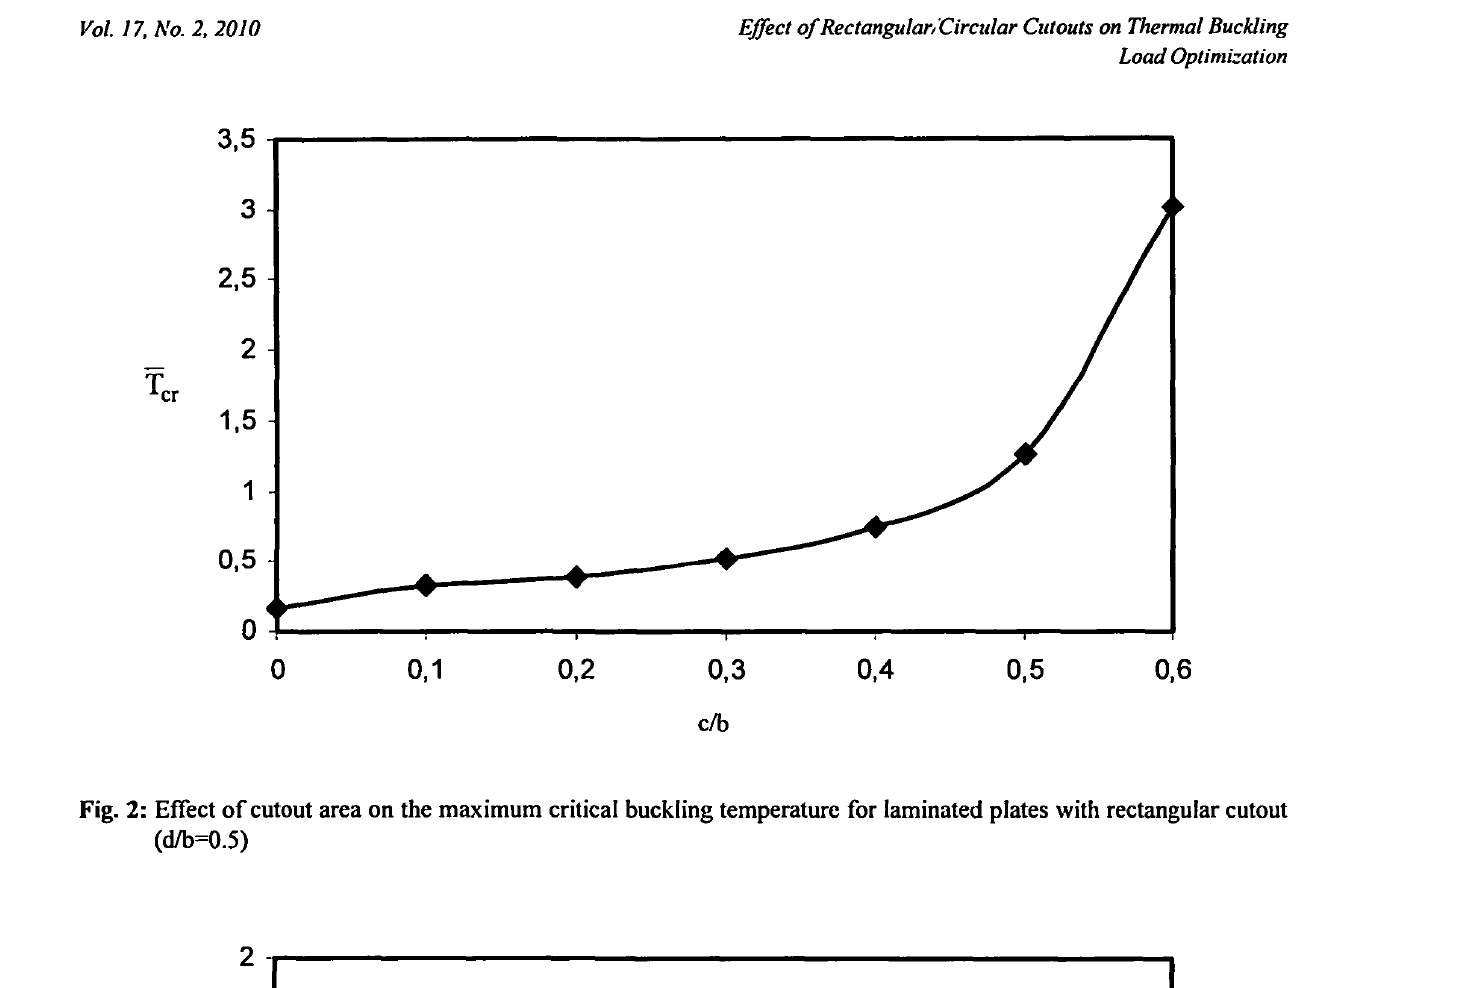
Fig. 2: Effect of cutout area on the maximum critical buckling temperature for laminated plates with rectangular cutout (d/b=0.5)